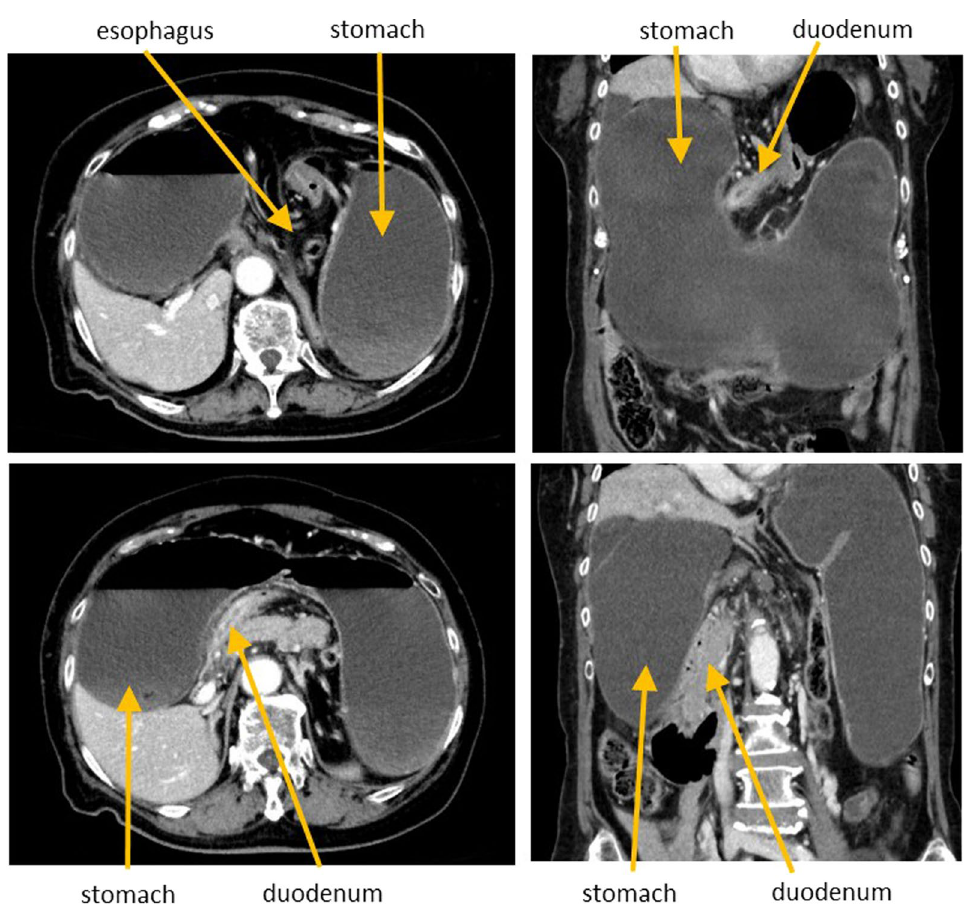
Fig. 2 Abdominal computed tomography showed mesentero-axial gastric volvulus (MAGV) with markedly dilated stomach and stenosis of the duodenum